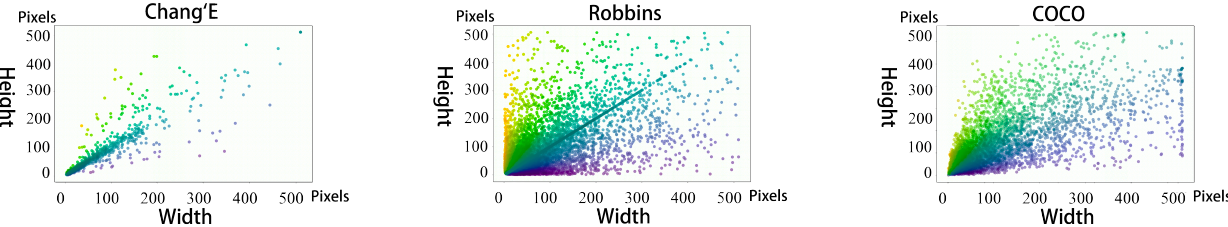
Figure 16. Comparison of the distributions of aspect ratio in Chang’e, Robbins and COCO